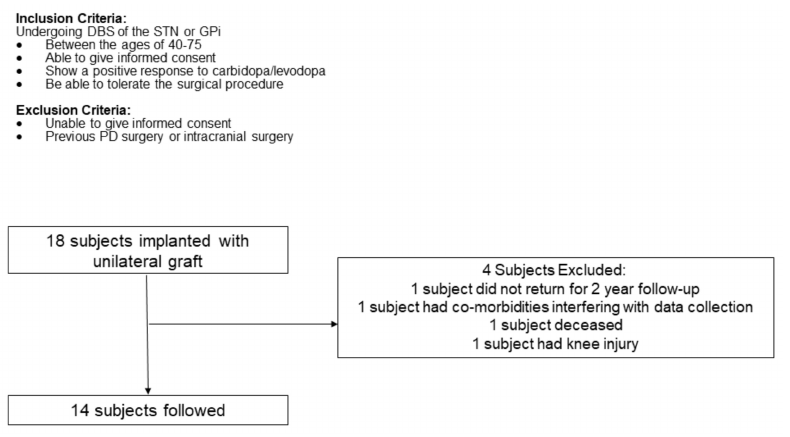
Figure 1. Participants inclusion